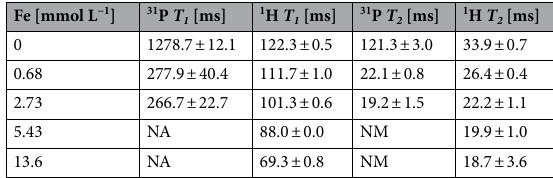
Table 2. 1 H (1.5 T) and 31 P (4.7 T) T 1 / T 2 relaxation times [ms] ± standard deviation. NA not applicable, NM not